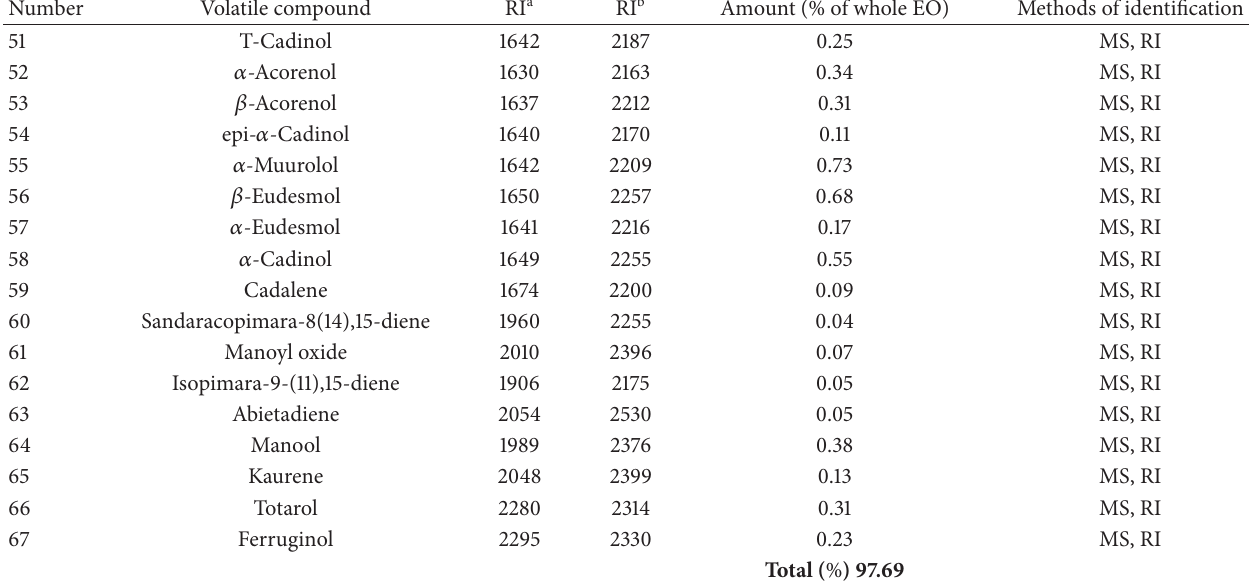
values, respectively, in the order of 2.89 mg ET/g DW and 3.39 mg ET/g